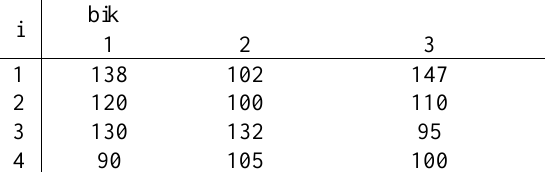
Table 3: Parameters of b